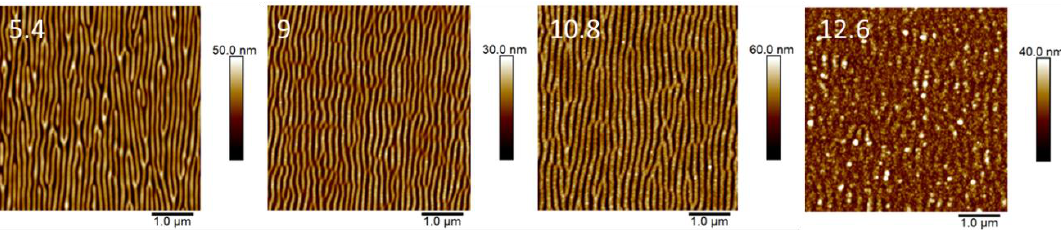
Figure 8. AFM topography images of LIPSS on PC 71 BM thin films at an irradiation wavelength of 266 nm with 3600 pulses as a function of fluence (mJ/cm 2 ) labeled on the top left corner.